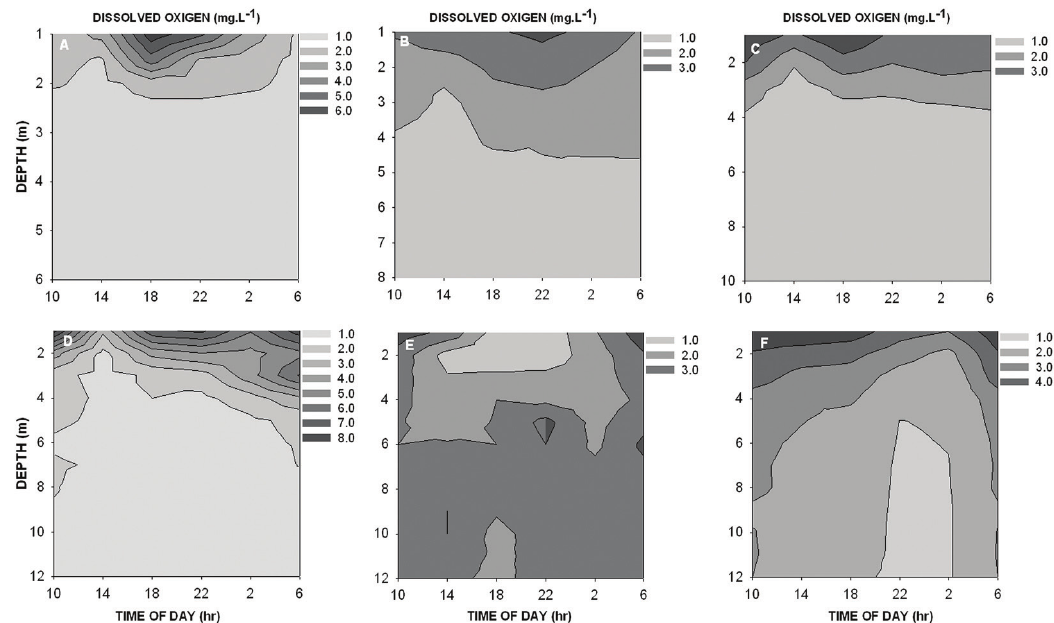
Figure 3. Daily variation in the vertical distribution of dissolved oxygen in Lago Catalão during the months of: A) November; B) February; C) March; D) April; E) May and F)